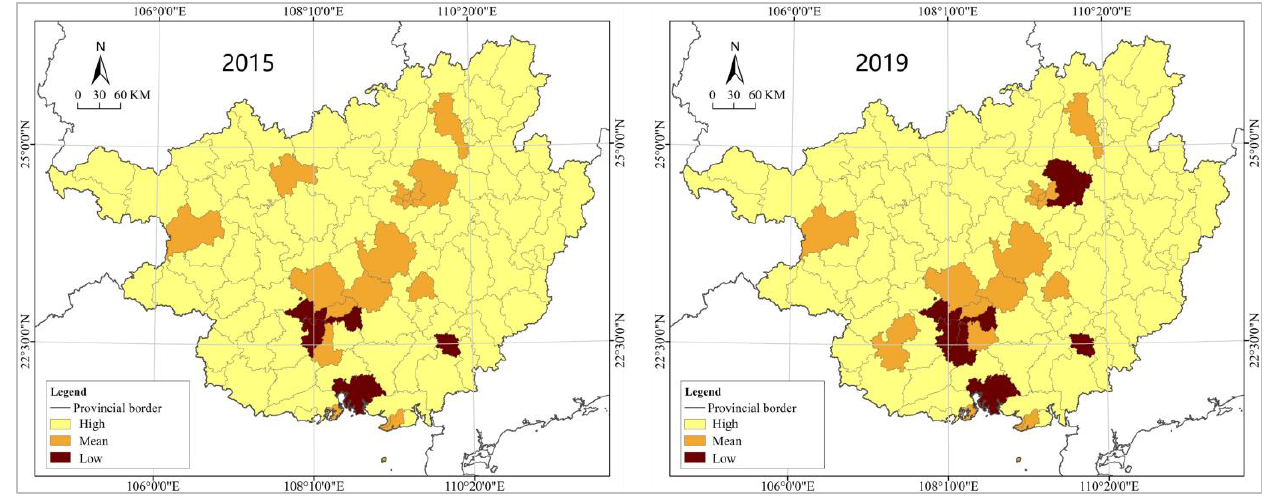
Figure 3. Spatial cluster analysis of urban night lighting index in Guangxi.